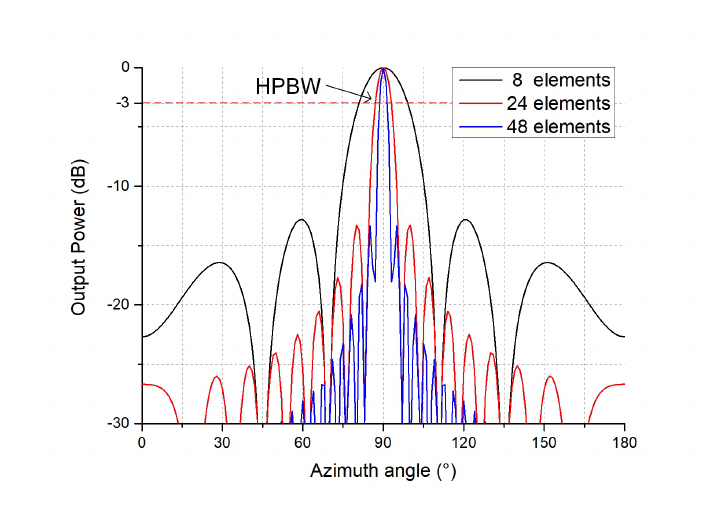
Figure 4. Beam pattern of arrays with different numbers of elements. HPBW: half power beam